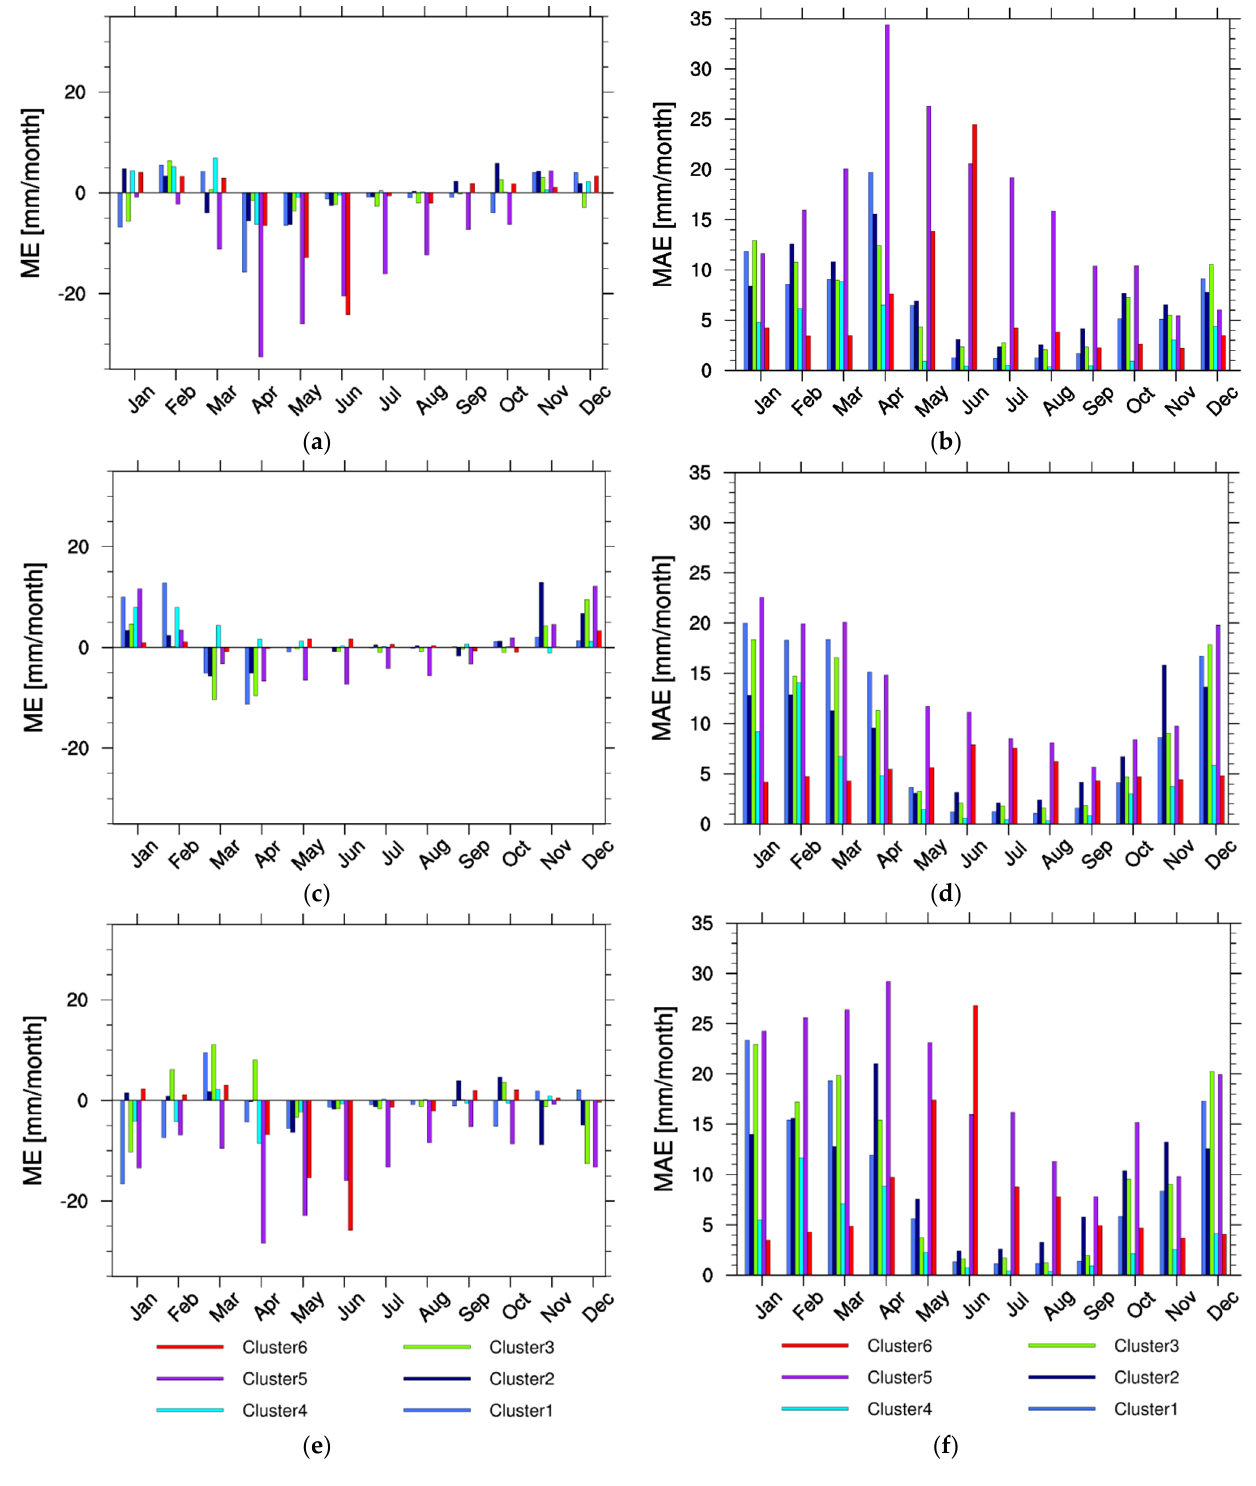
Figure 10. Same as in Figure 7 but for SA: TAMSAT3 with respect to CHIRPS ( a , b ), MSWEP with respect to CHIRPS ( c , d ), and TAMSAT3 with respect to MSWEP ( e , f ) .